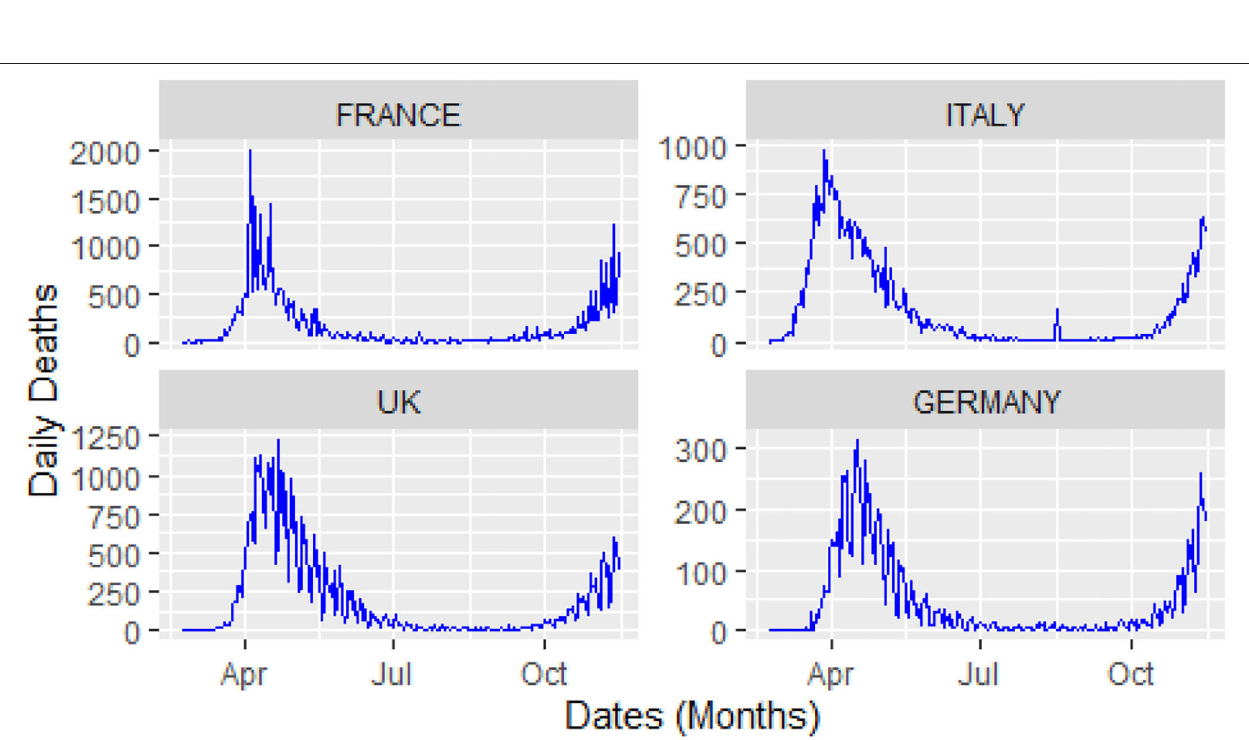
FIGURE 4 | Daily deaths: time window from 23 February 2020 to 14 November 2020.